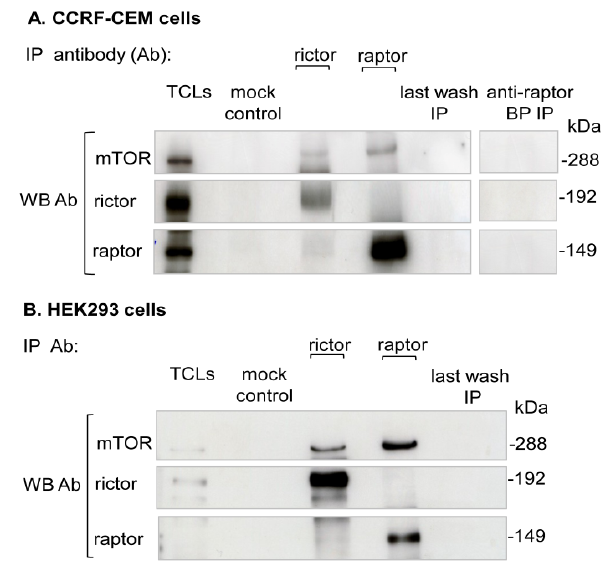
Figure 1. Endogenous mTORC1 purification: ( A ) CCRF-CEM or ( B ) HEK293 cells were grown for 48 h in complete medium and lysed as described in the Methods section. Endogenous mTOR complexes were immunopurified from total cell lysates (TCLs) using raptor or rictor antibodies. Mock (beads and whole cell lysates without antibody) or rictor immunoprecipitation (IP), last IP wash and anti-raptor blocking peptide (BP, which represents the epitope of the raptor antibody used for neutralization) were all included as purification controls. After immunopurification, the IP elutes were resolved on SDS-PAGE and then immunoblotted with corresponding antibodies. All experiments were independently repeated four times in each cell line (CCRF-CEM cells: n = 4; HEK293 cells: n = 4). WB in the figure represents Western